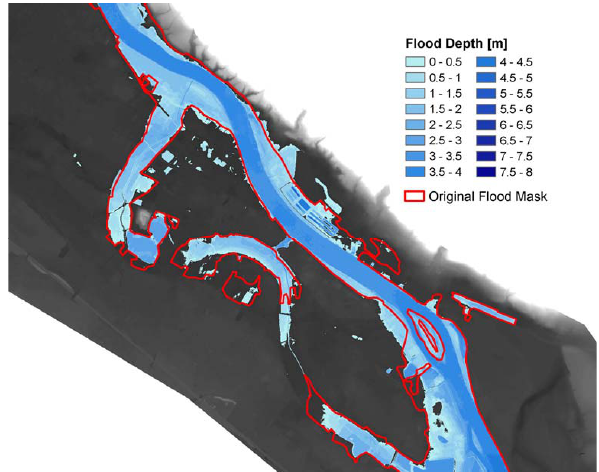
Fig. 10. Flood depth map of the Elbe River region southeast of Dresden showing the result of the computed flood depth and the resulting flood extent at the time of the Ikonos satellite overpass compared to the original flood mask